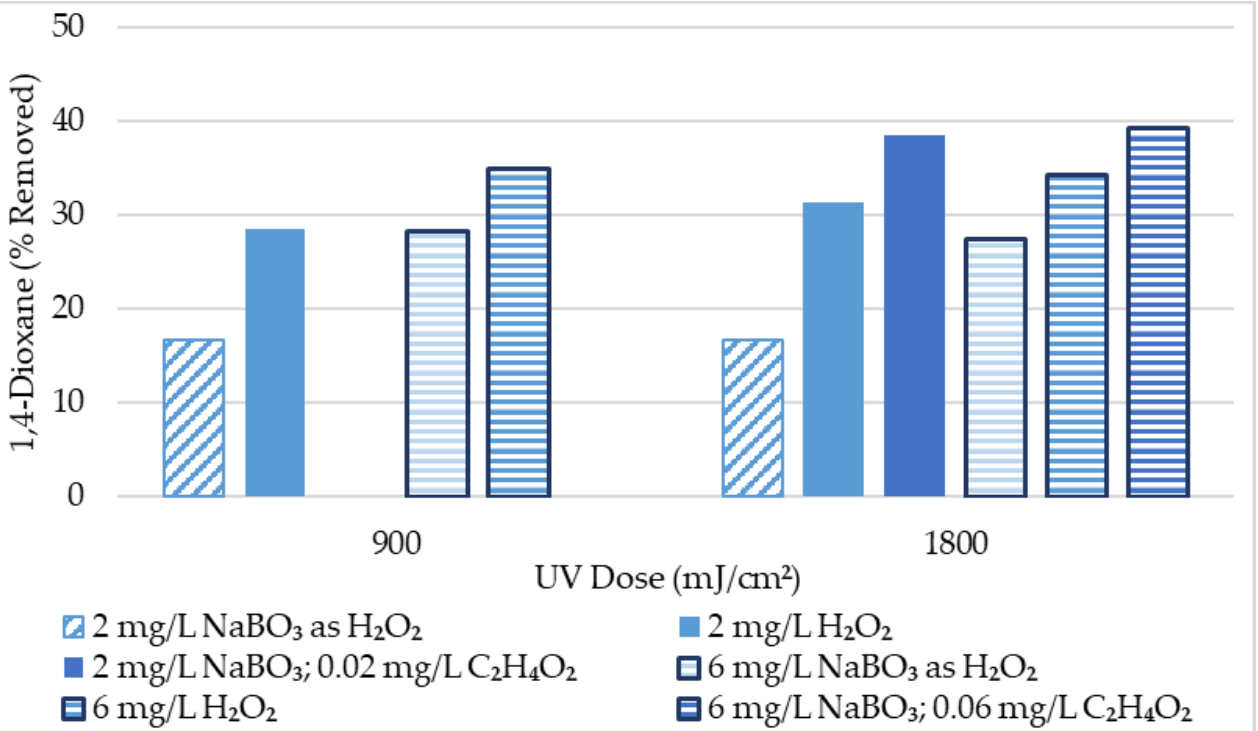
Figure 2. 1,4-Dioxane Initial Screening Results Summary (10 μg/L initial 1,4-dioxane conc.).